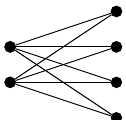
Figure 4.1: Non-Hamiltonian graph K 2,3 for which the inequality (4.1) does not